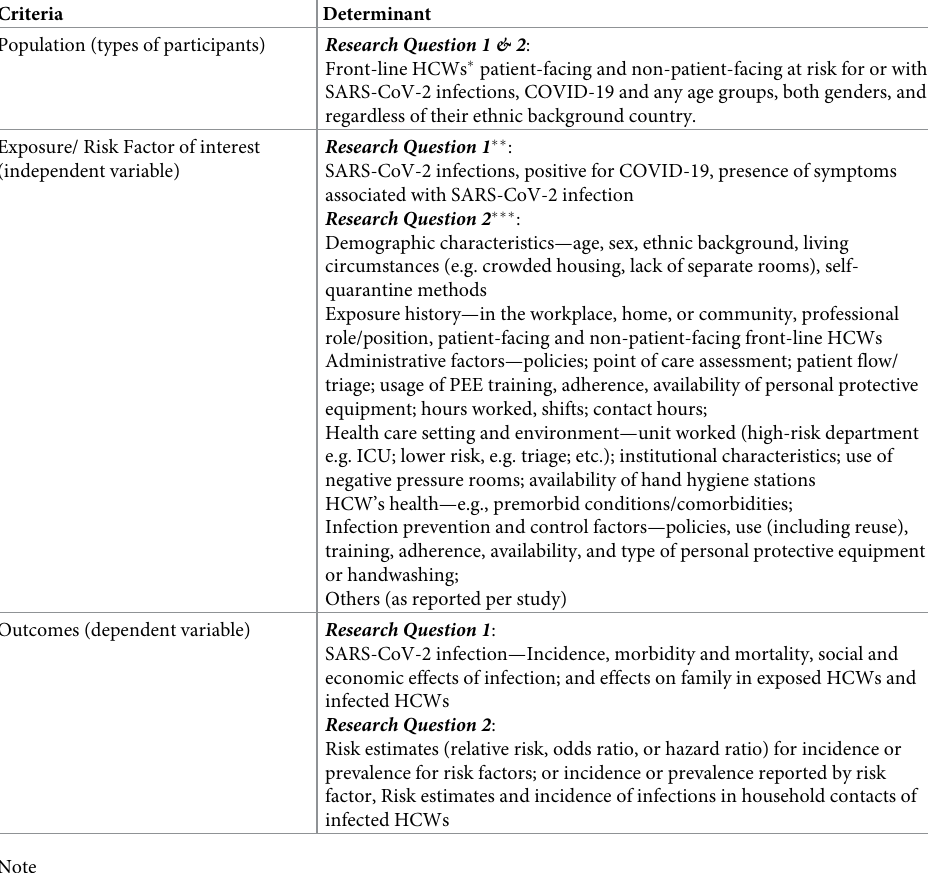
Table 1. PEO framework for determining the eligibility of the research